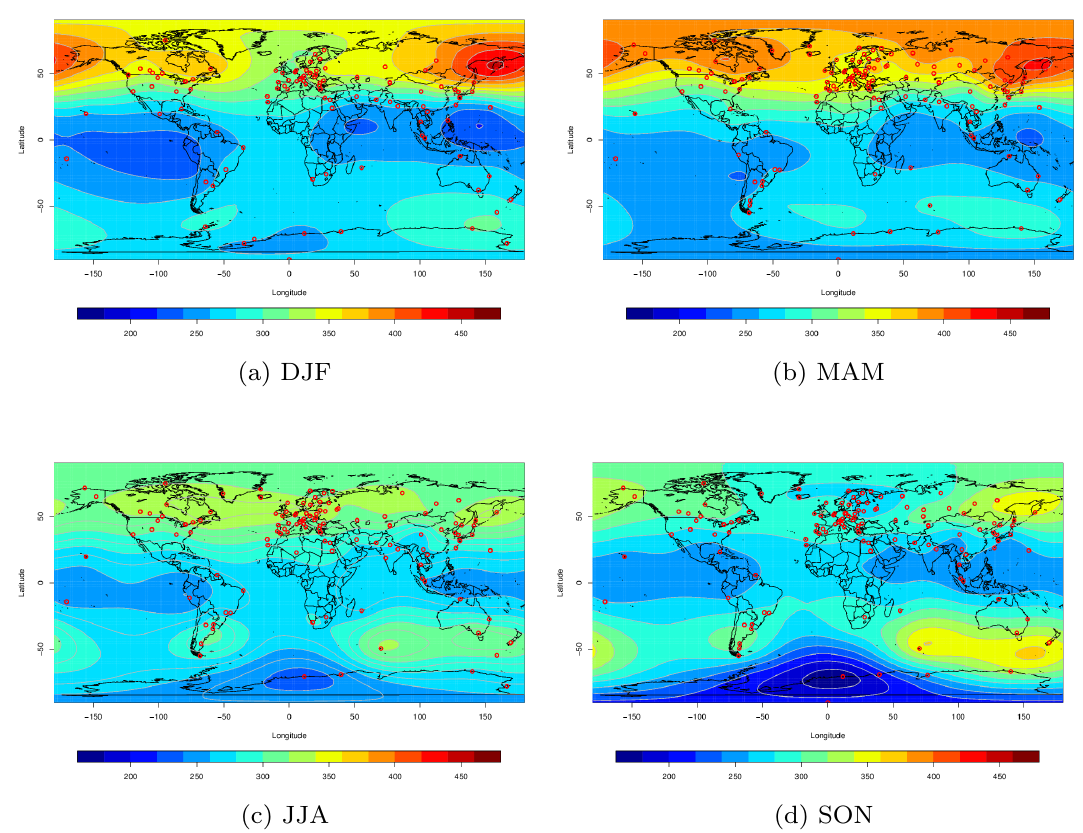
Figure 2. Surface predicted ozone (DU) mean from SPDE approach (strategy D) by season from 2000.